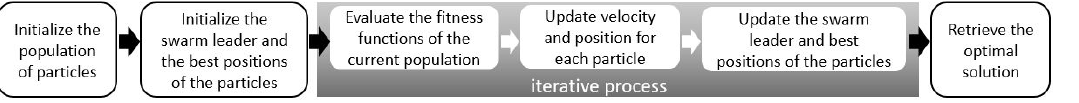
Figure 2. Basic flowchart of the PSO.